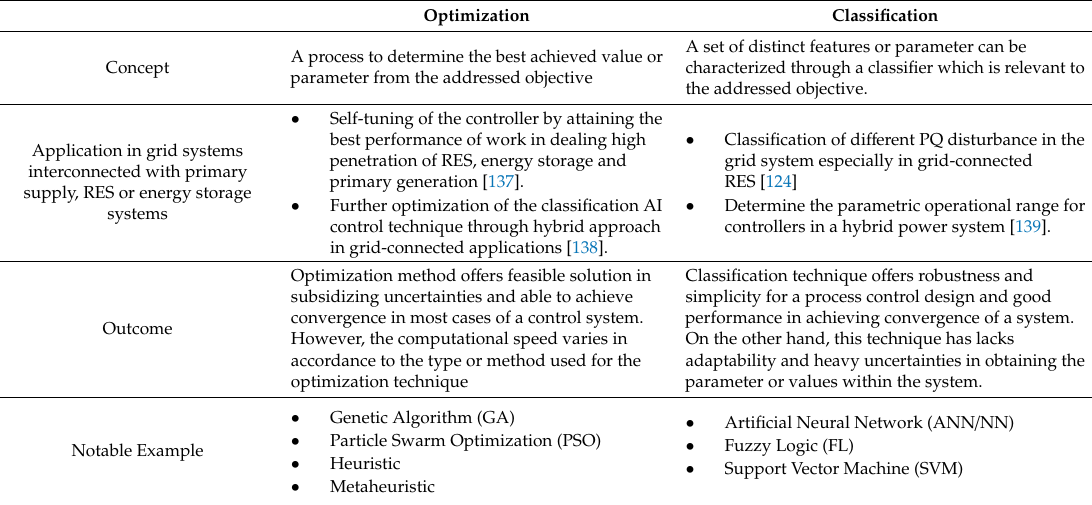
Table 5. Concept and examples of optimization and classification Artificial Intelligence control